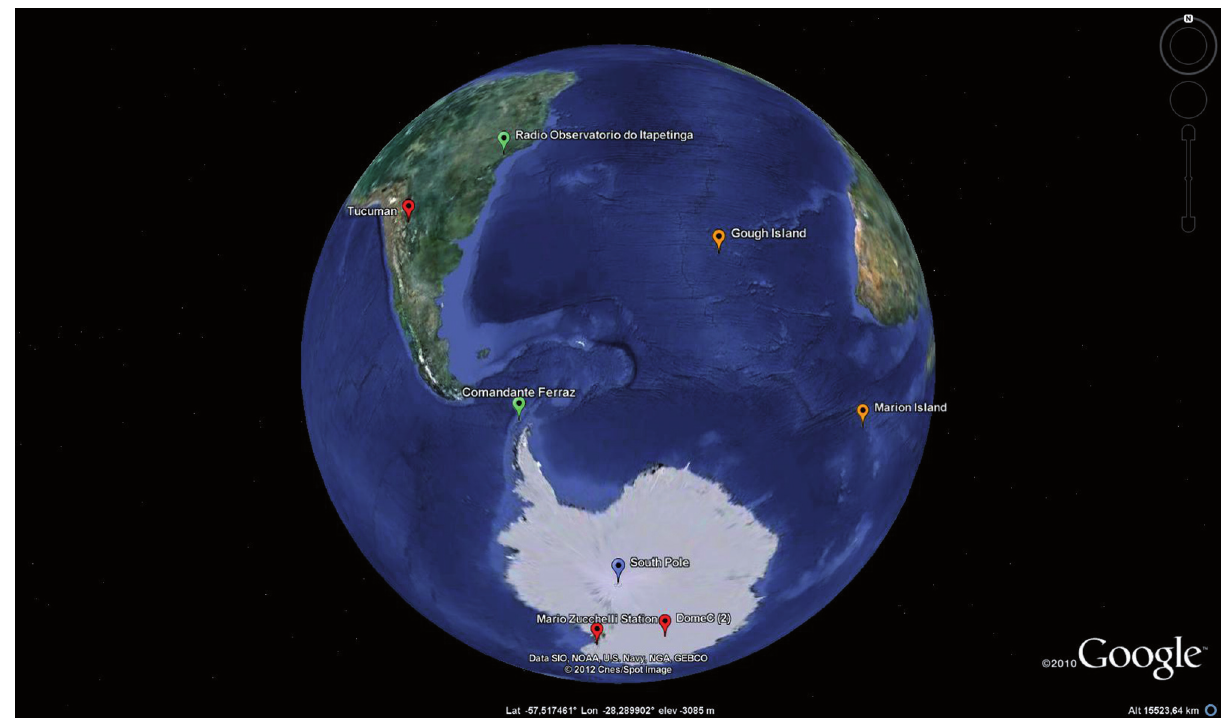
Figure 1. Location of the receivers used in this